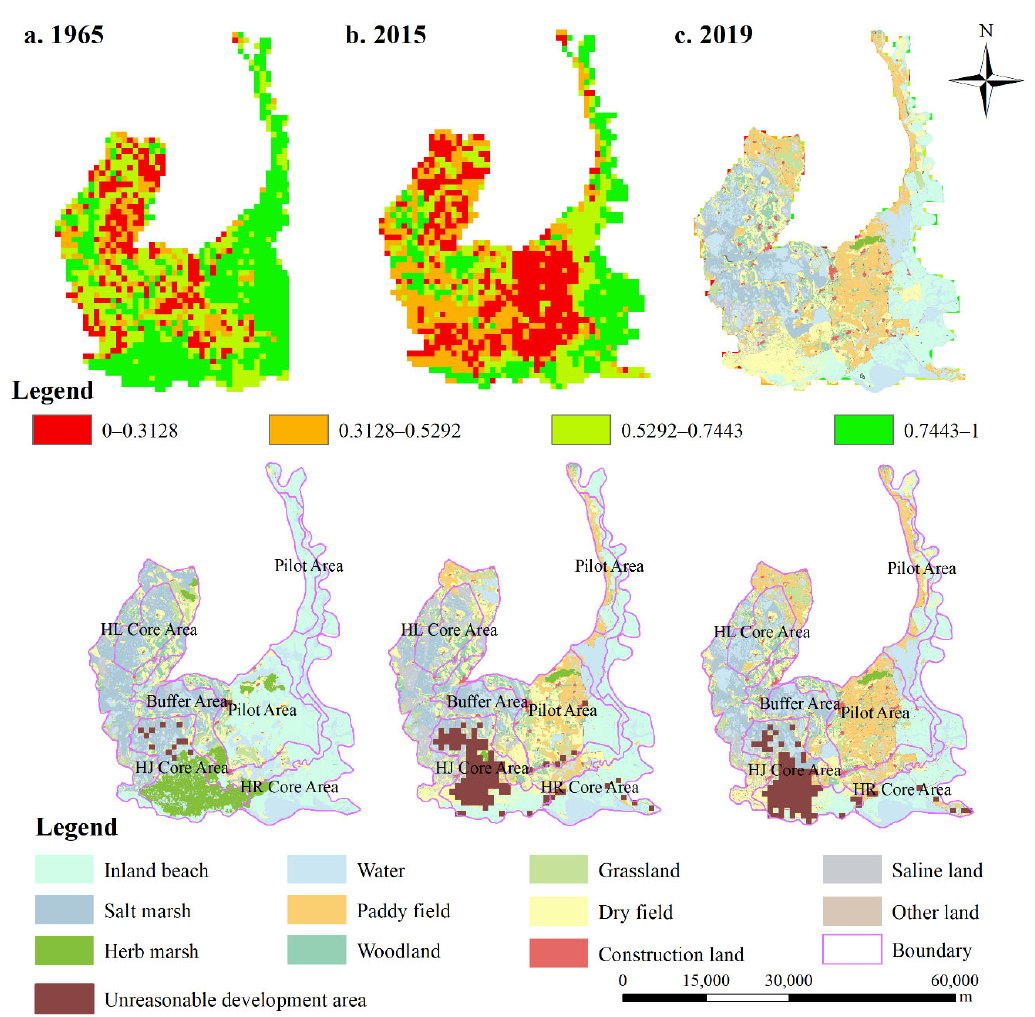
Figure 10. E cosystem integrity assessment and identification of unreasonable development areas for the Momoge Internationally Important Wetland in 1965, 2015, and 2019. the Momoge Internationally Important Wetland in 1965, 2015, and